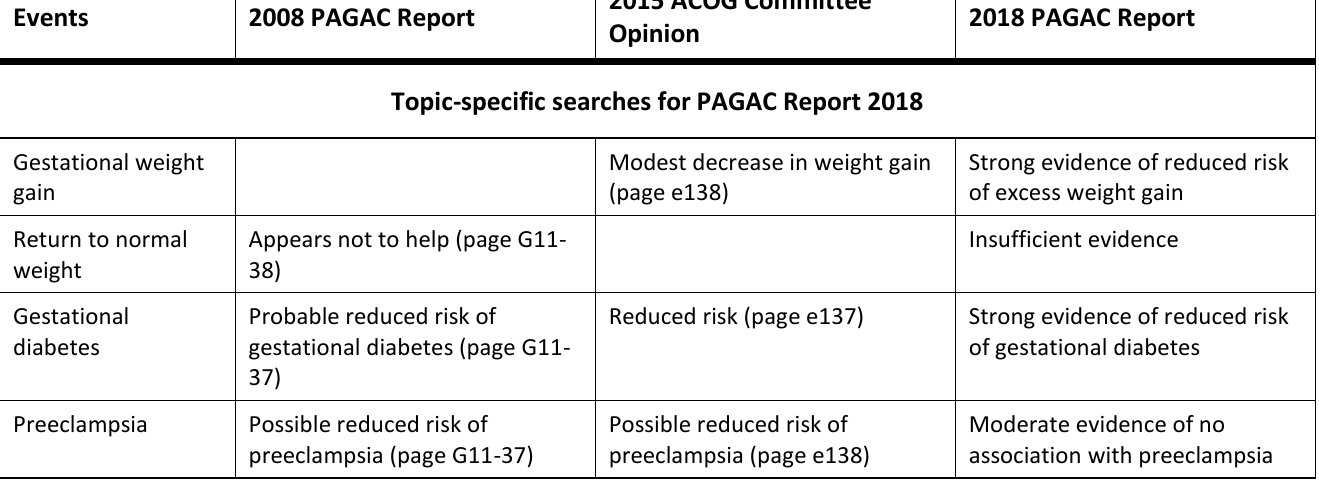
Table F8-3. Effects of Physical Activity on Pregnancy- and Postpartum-Related Events